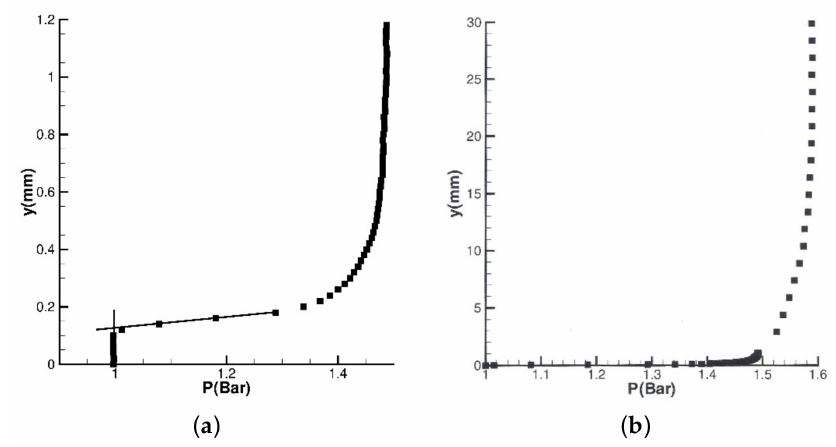
Figure 5. ( a ) Nozzle exit total profile Near-wall, LU60, NPR = 1.58; ( b ) Nozzle exit total profile Full radius, LU60, NPR =